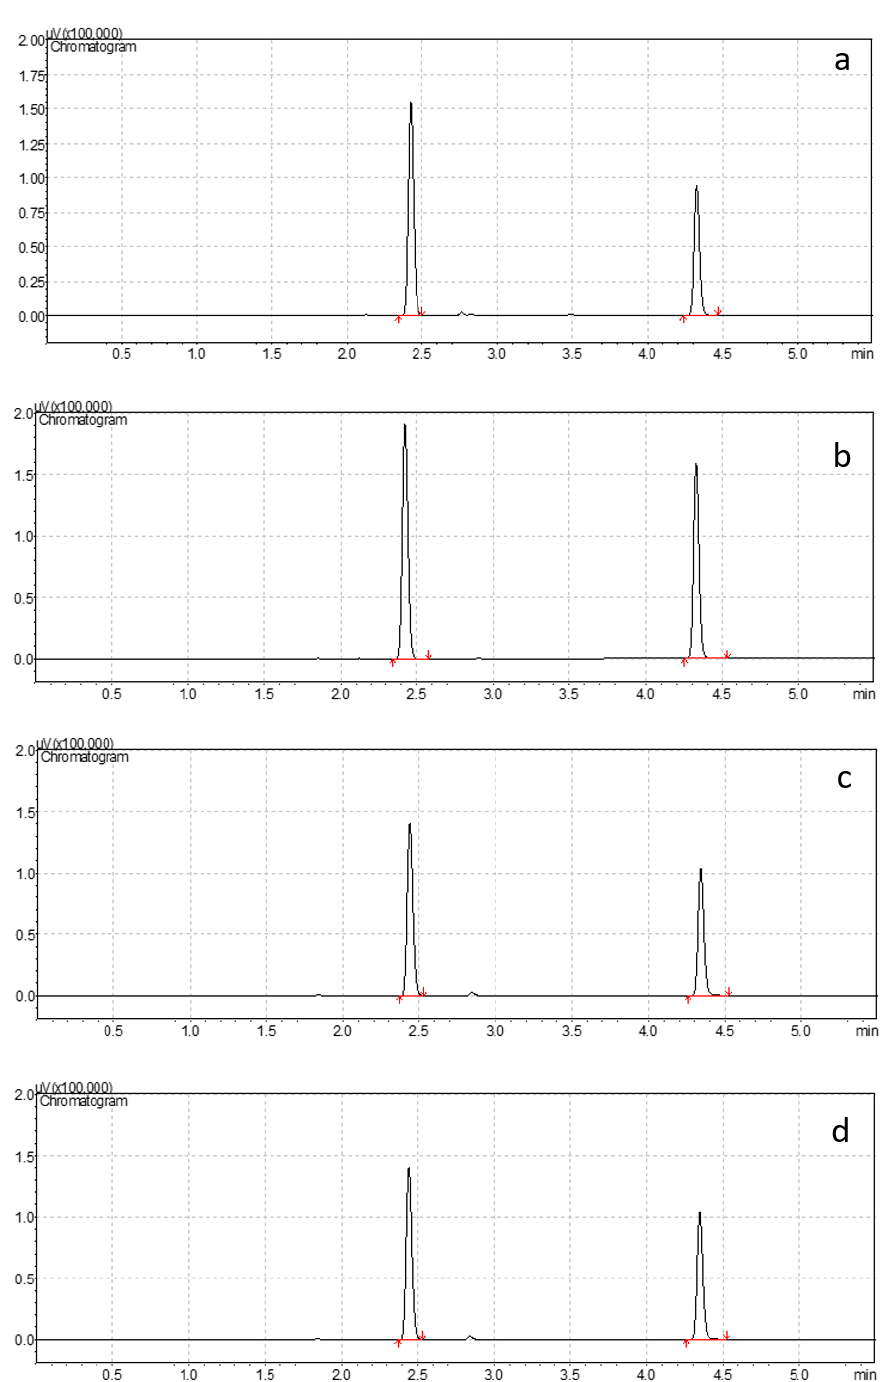
Figure 5. Chromatograms of the medium QC in the blood ( a ), urine ( b ), brain ( c ), lung ( d ). Retention times: sevoflurane 2.43; IS 4.34.